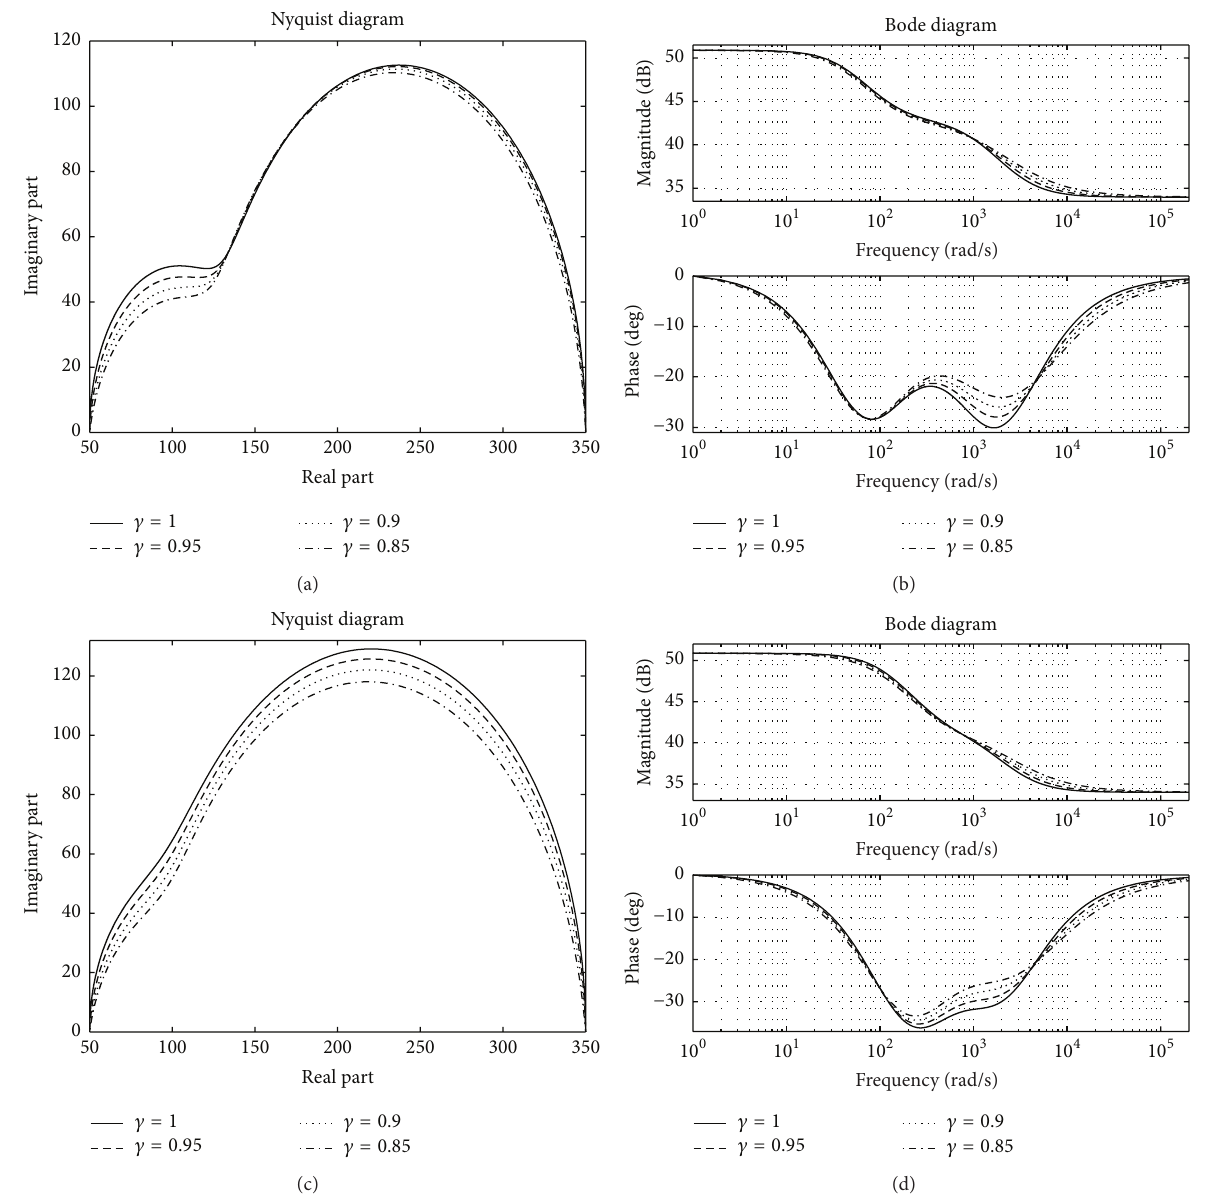
Figure5:NyquistandBodediagramfortheheterogeneousreactionmodel,Caputoderivativeapproach,in(a)and(b): 𝑅 1 = 50Ω , 𝑅 2 = 100 Ω , = 200 Ω , 𝐶 = 1 −3 F, and 𝐶 = 1 −2 F for 𝛾 = 1 , 𝛾 = 0.95 , 𝛾 = 0.9 , and 𝛾 = 0.85 ; for (c) and (d), 𝑅 𝑅 3 1 2 = 1 −3 F, and 𝐶 = 3 −3 F for 𝛾 = 1 , 𝛾 = 0.95 , 𝛾 = 0.9 , and 𝛾 = 0.85 . The capacitor 𝐶 𝐶 1 2